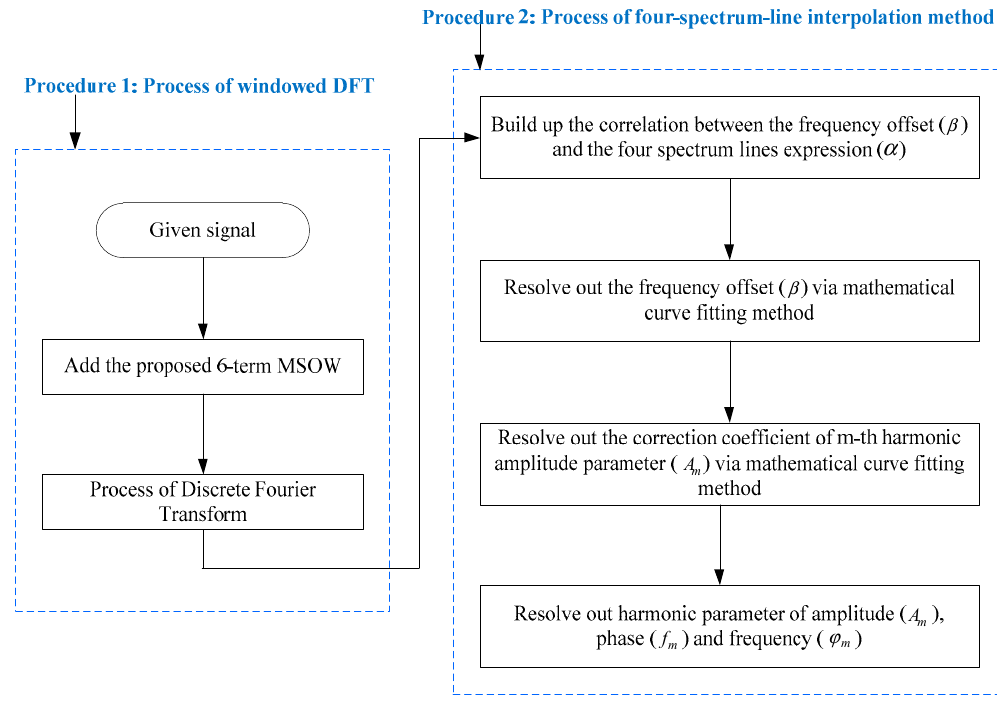
Figure4. Figure 4. Flow chart of the proposed improved discrete Fourier transform (DFT) harmonic detection algorithm.